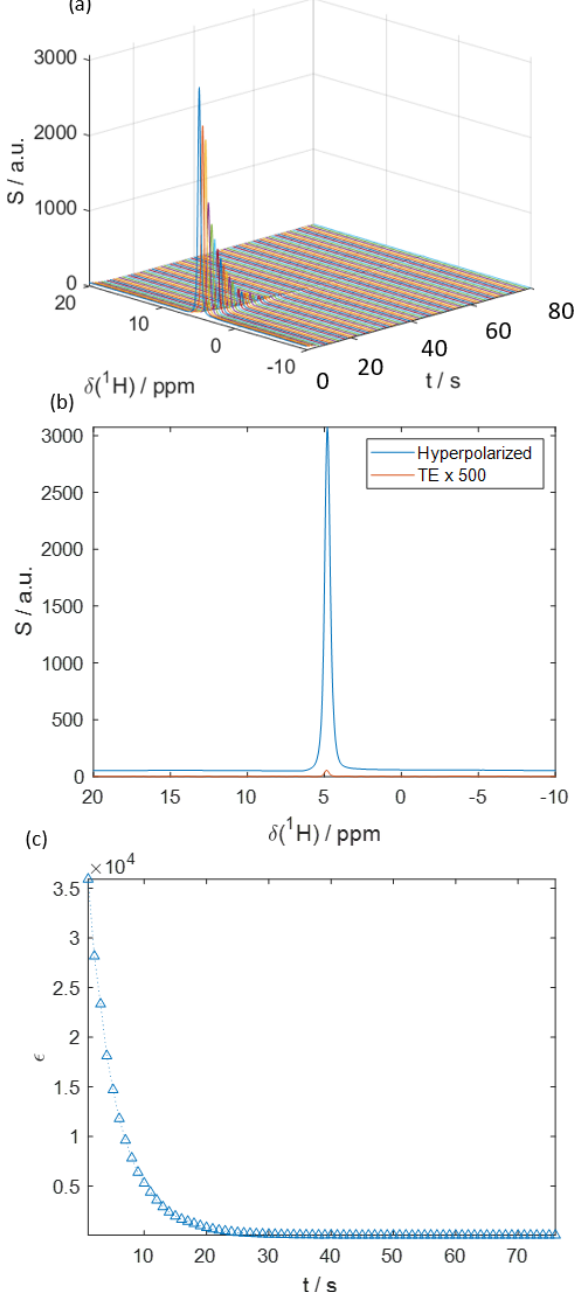
Figure 5. (a) Time series of 1 H-detected spectra of hyperpolarized HDO at B 0 = 1T. At t = 0s the hyperpolarized liquid is injected into the spectrometer. The transfer took ca. 1s over a length of 1.5m. (b) The HDO spectrum directly after injection (blue) com- pared to the signal in thermal equilibrium (orange). The signal en- hancement was ε ≈ 36000, corresponding to a 1 H polarization of P ( 1 H) ≈ 12%. The detection flip angle was α = 10 ◦ . (c) Decay of the signal enhancement in comparison to thermal equilibrium with time after injection. The mono-exponential decay rate constant R 1 was fitted to 0 . 21 ± 0 . 03s − 1 .